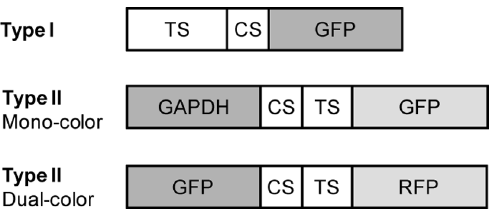
Figure 1. Schematic illustration of MBR proteins used in this study. One type I and two different type II MBRs were constructed. Either GAPDH or GFP was used as a masking protein for mono-color or dual-color type II MBR, respectively. TS; translocation signal, CS; cleavage sequence, GFP; green fluorescent protein, GAPDH; glyceral- dehydes 3-phosphate dehydrogenase. RFP; red fluorescent protein.